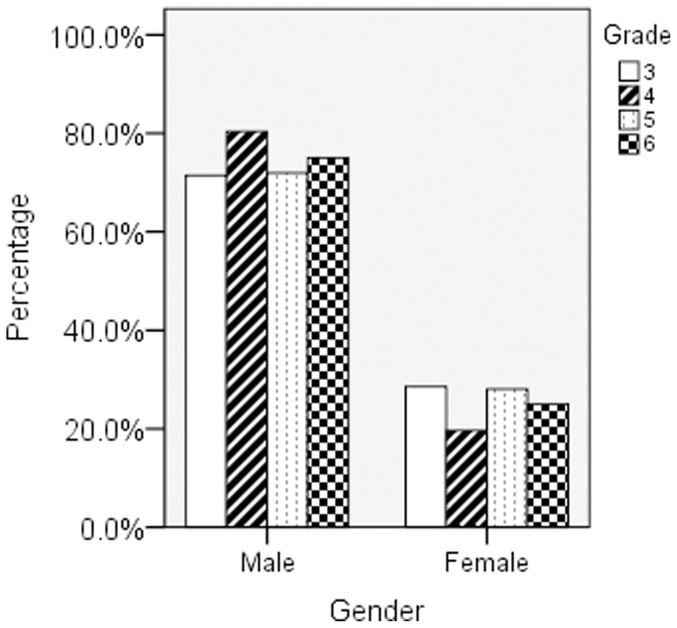
The distribution of dyslexia in grade and gender.